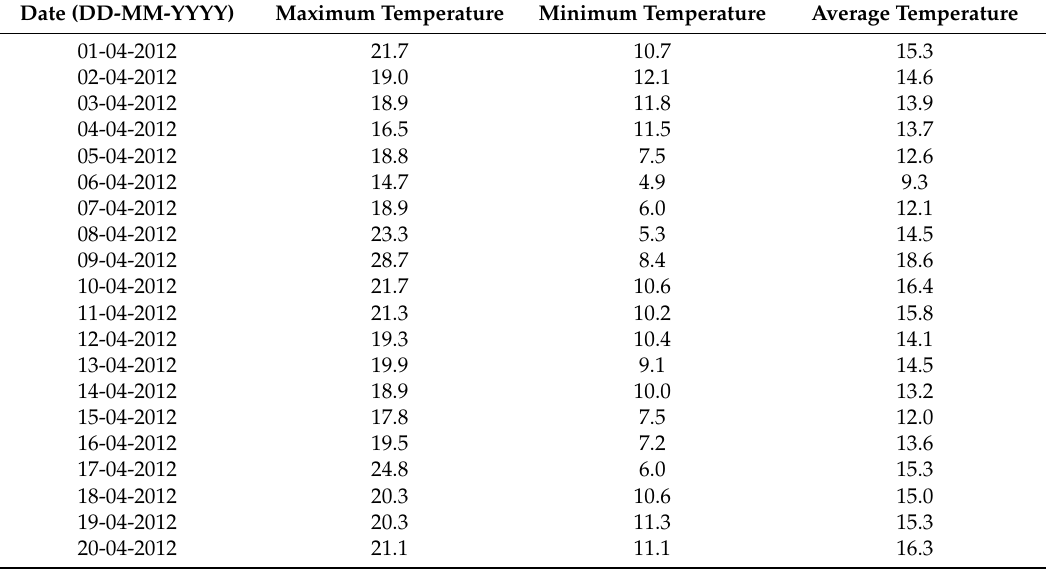
Table A4. Maximum, minimum, and average environmental temperatures ( ◦ C) recorded in the study area during the selective pruning period in